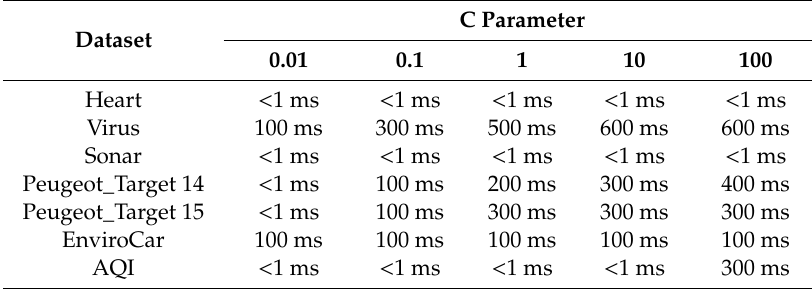
Figure 3. Accuracy vs. Epochs for ( a ) Heart, ( b ) Virus, ( c ) Sonar, ( d ) Peugeot target 14, and ( e ) Peugeot target 15. Table 34. Training time for di ff erent values of the C